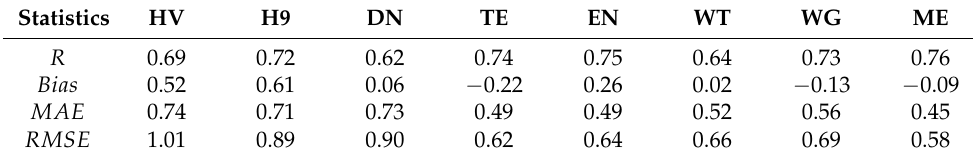
Table 3. NCACN 20 C 2 n profiles